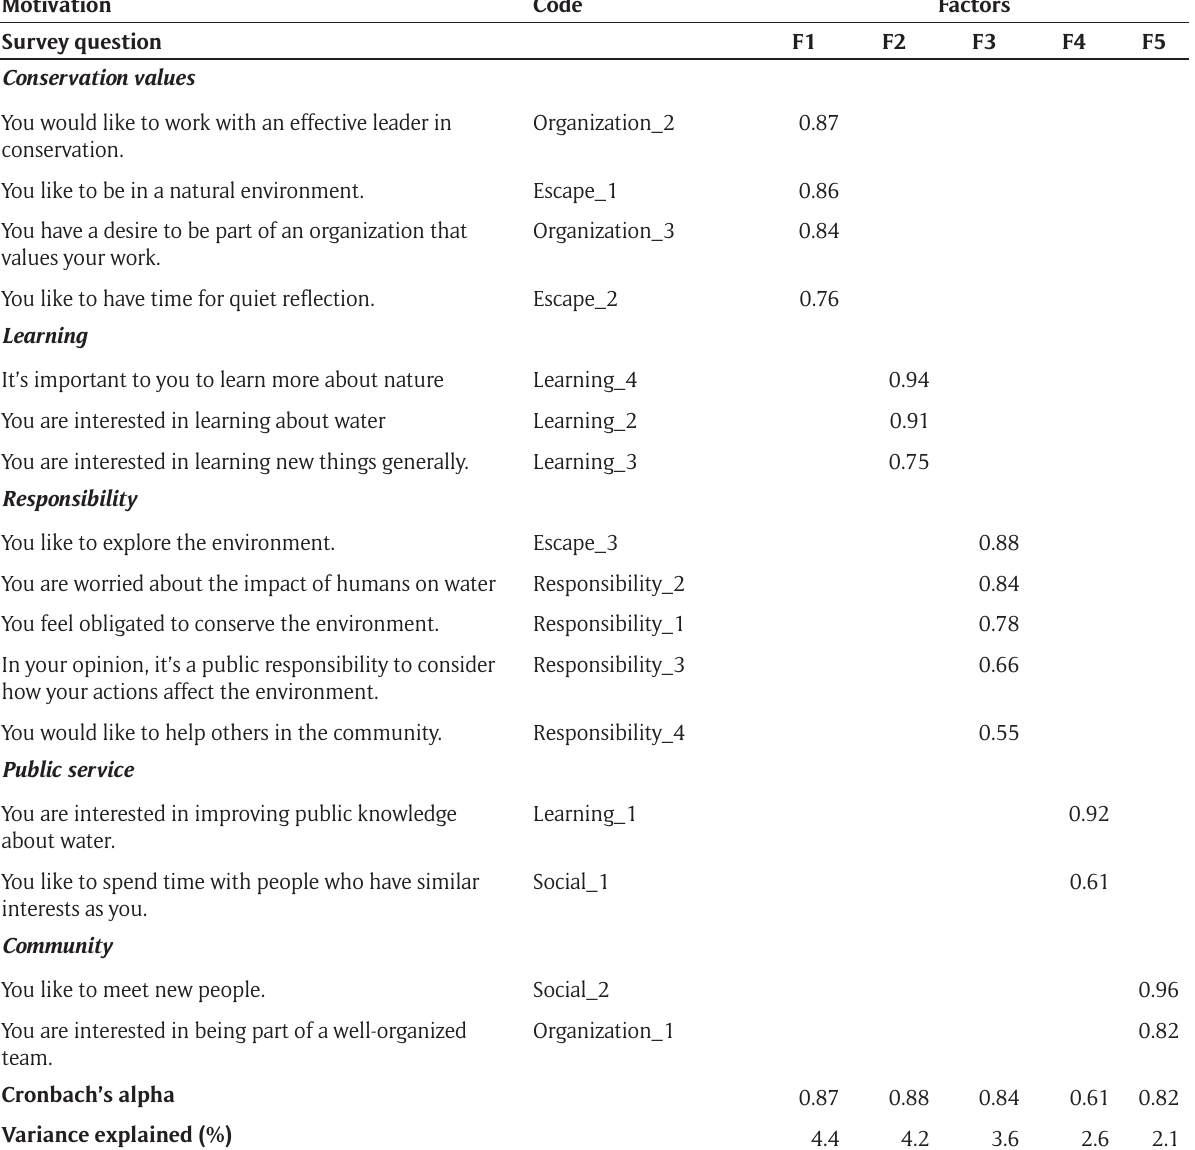
Table 2: Principal component analysis of motivational factors for participation in citizen